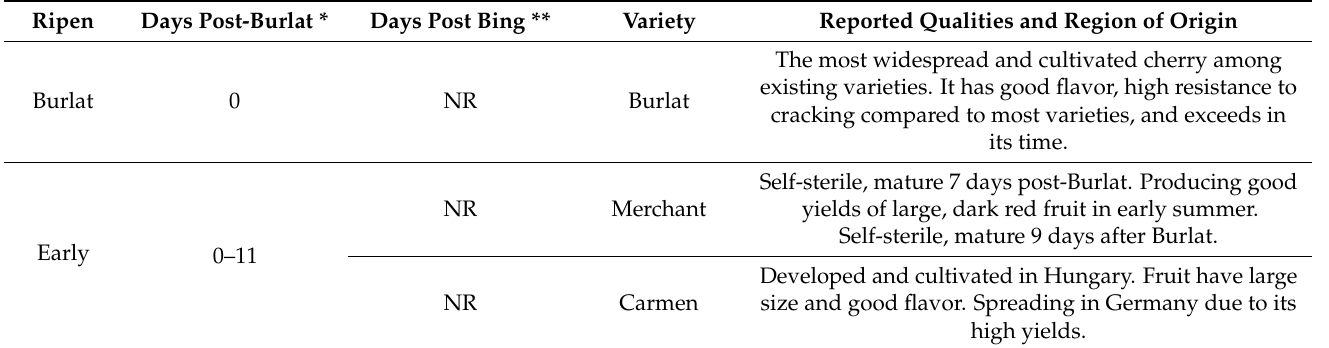
Table 1. Some of the most commonly commercially cultivated varieties of sweet cherry. Early, mid and late ripening types based on the ripening of the reference variety, Burlat, a widespread cultivated cherry across Europe. Comparisons to the variety Bing are based on interviews with growers in Stanislaus County, California and on published data. NR—not